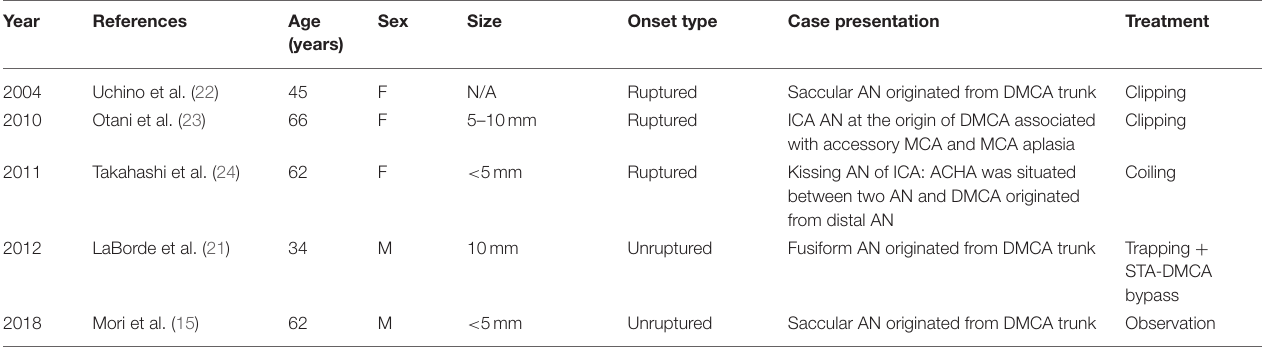
TABLE 1 | Rare variations of DMCA